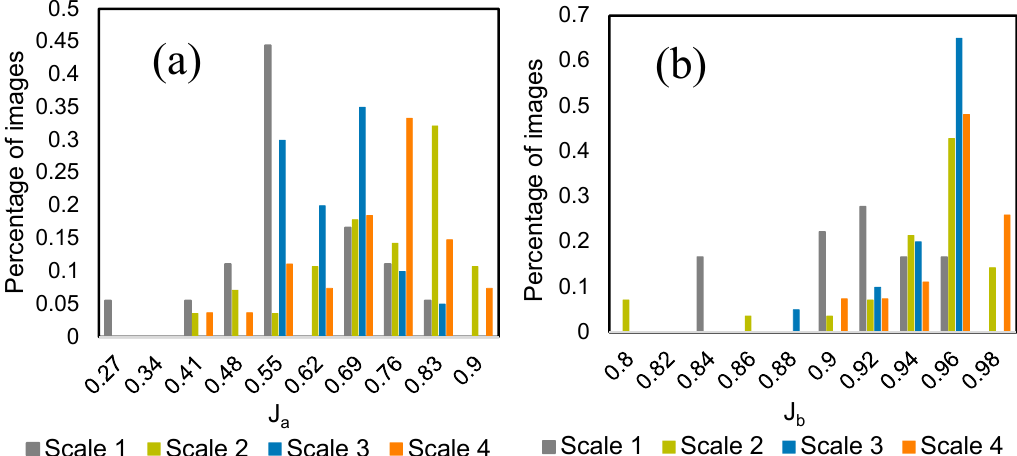
Figure 5. Distribution of Jaccard index J for ( a ) the awns and ( b ) spike bodies grouped according to the scale of spatial resolution.